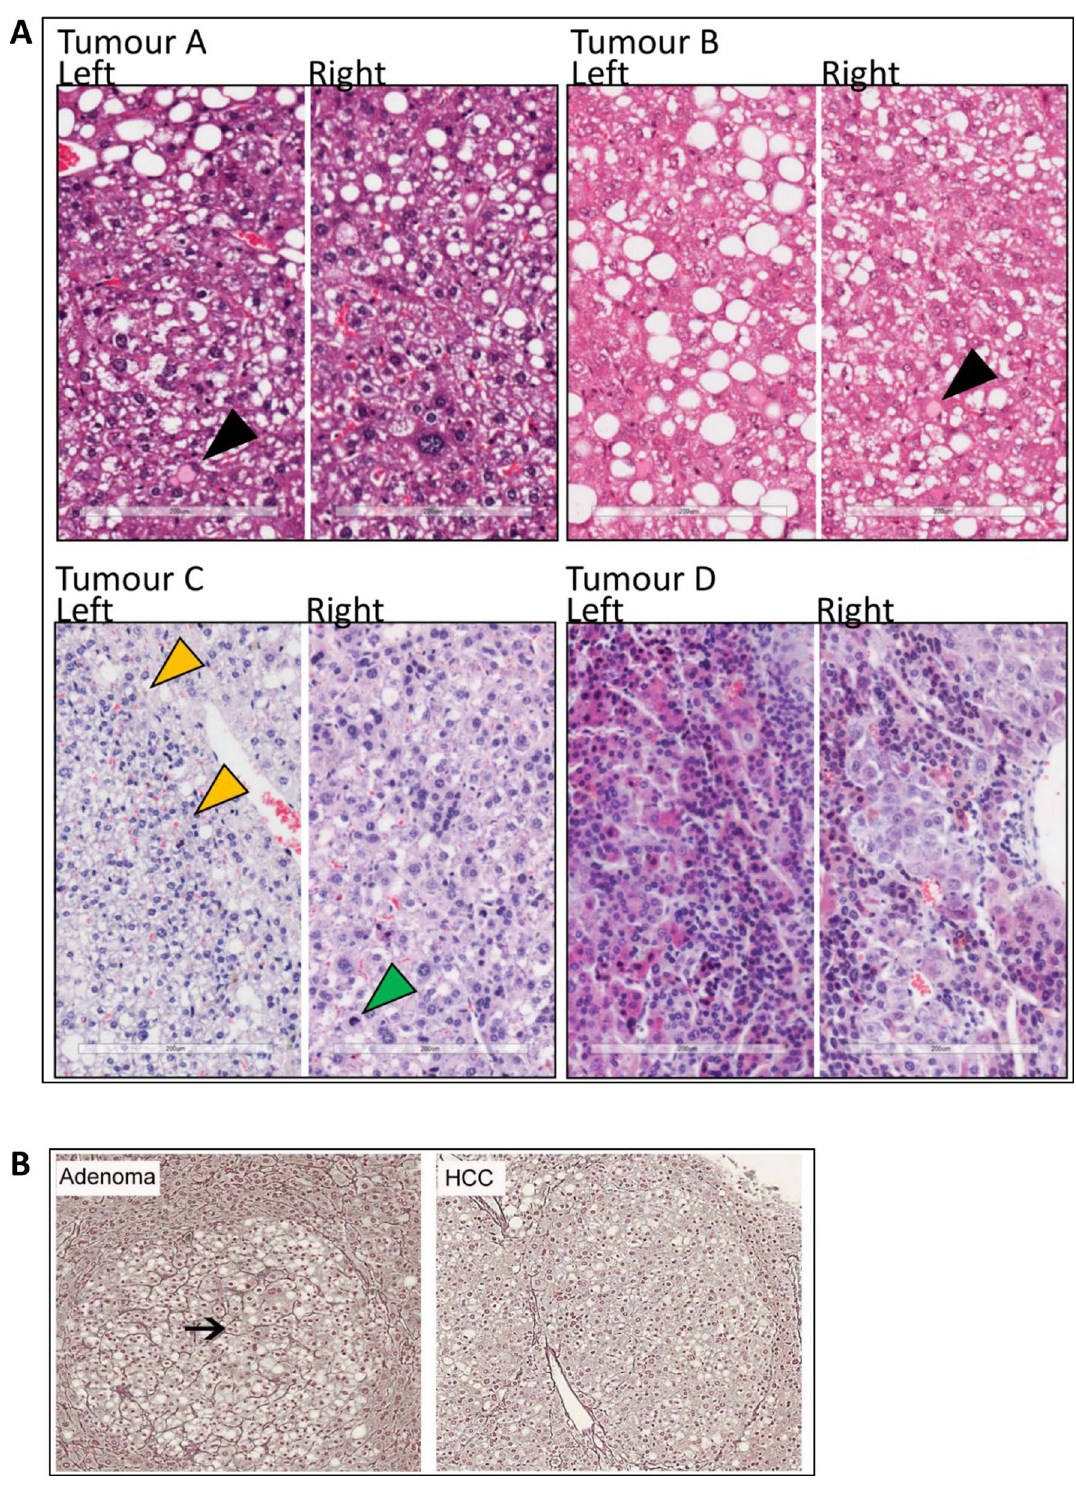
Figure 4. DINAH model histopathology features of HCC. Heamatoxylin and Eosin immunohistochemistry from 4 tumours is shown ( A ). Tumours A and B are hepatocellular neoplasms showing steatosis, focally increased nuclear-cytoplasmic ratio, nuclear atypia and eosinophilic cytoplasmic inclusions (black triangles) in keeping with HCC. In tumour C, yellow triangles (left) highlight bile production, with green triangle (right) showing a mitotic figure also indicative of HCC. Silver stain shows preservation of reticulin between liver cell plates in an adenoma (black arrow), with loss of reticulin and thickened liver cell plates in a tumour classed HCC ( B